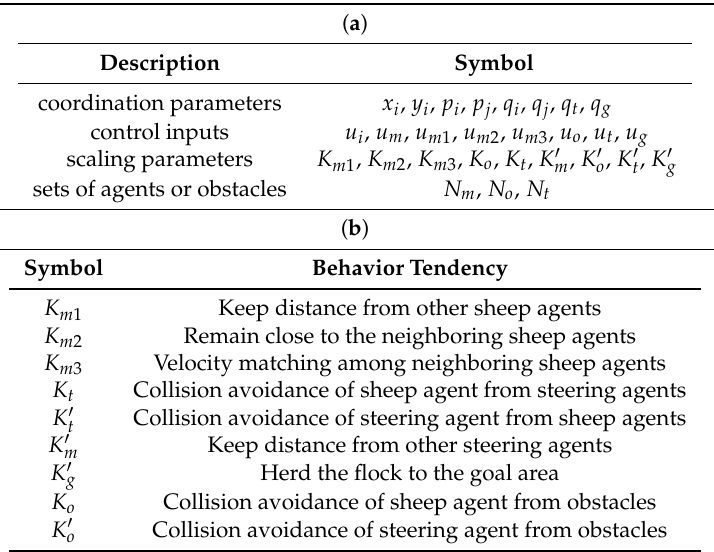
Table 1. Description of the parameters in the control algorithm: ( a ) list of all parameters; ( b ) behavior tendency corresponding to the scaling